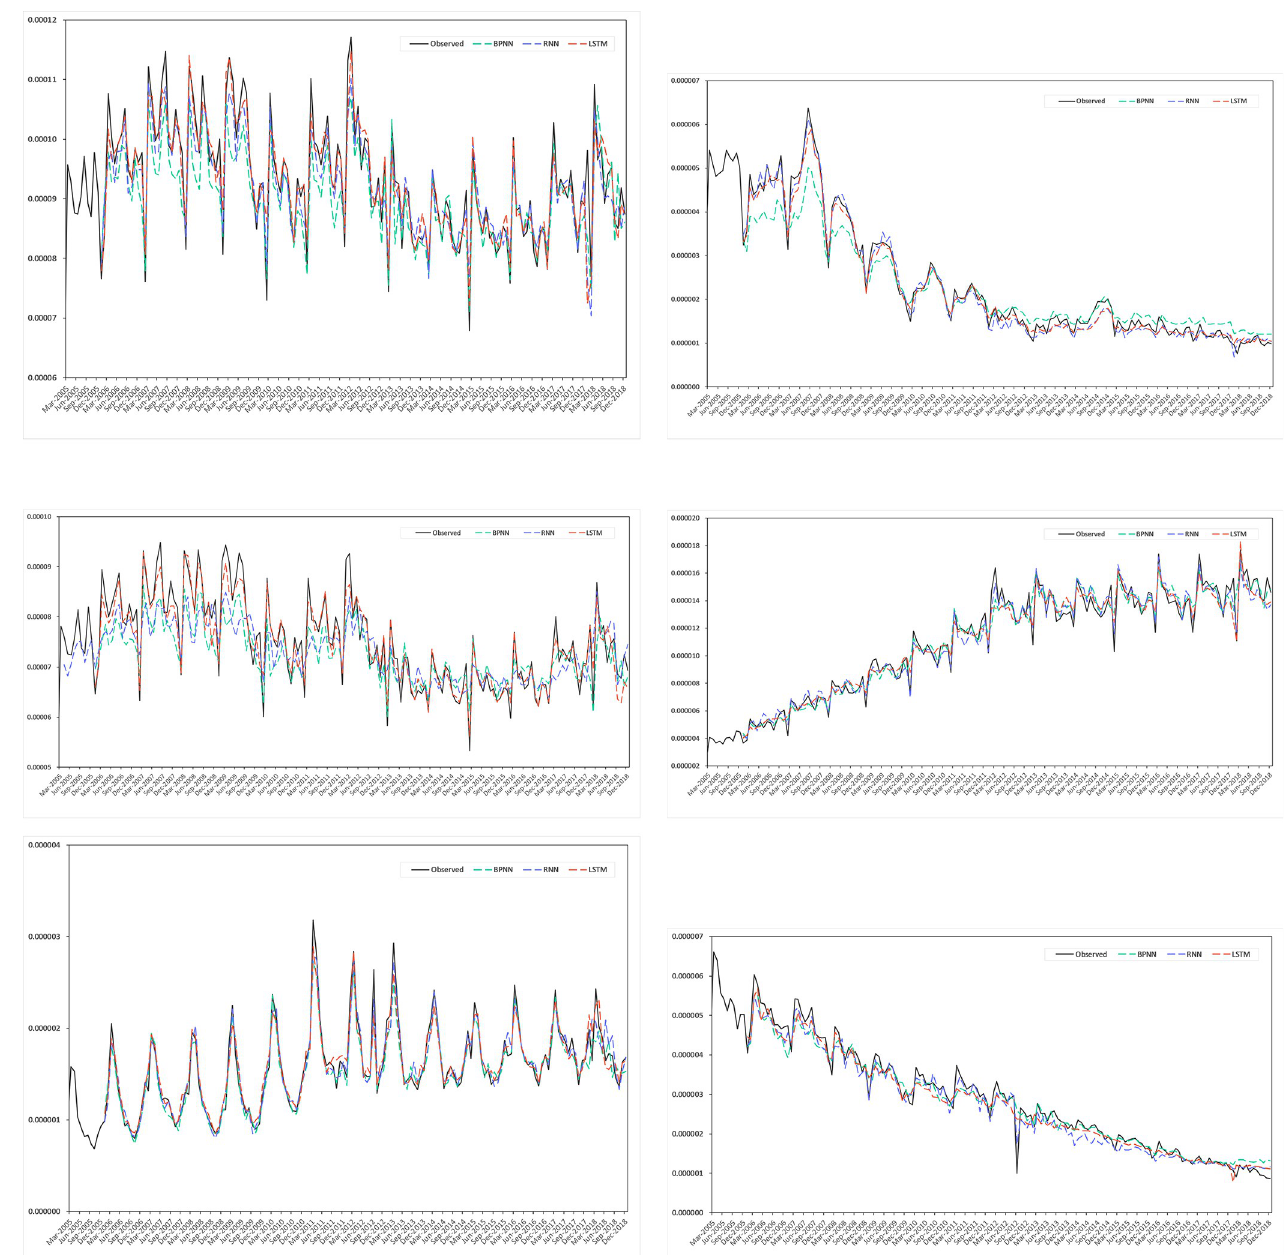
Fig 4. Incidence and fitting values of Hepatitis predicted by three neural network models. (a) Hepatitis, (b) Hepatitis A, (c) Hepatitis B, (d) Hepatitis C, (e) Hepatitis E, (f) Hepatitis U.